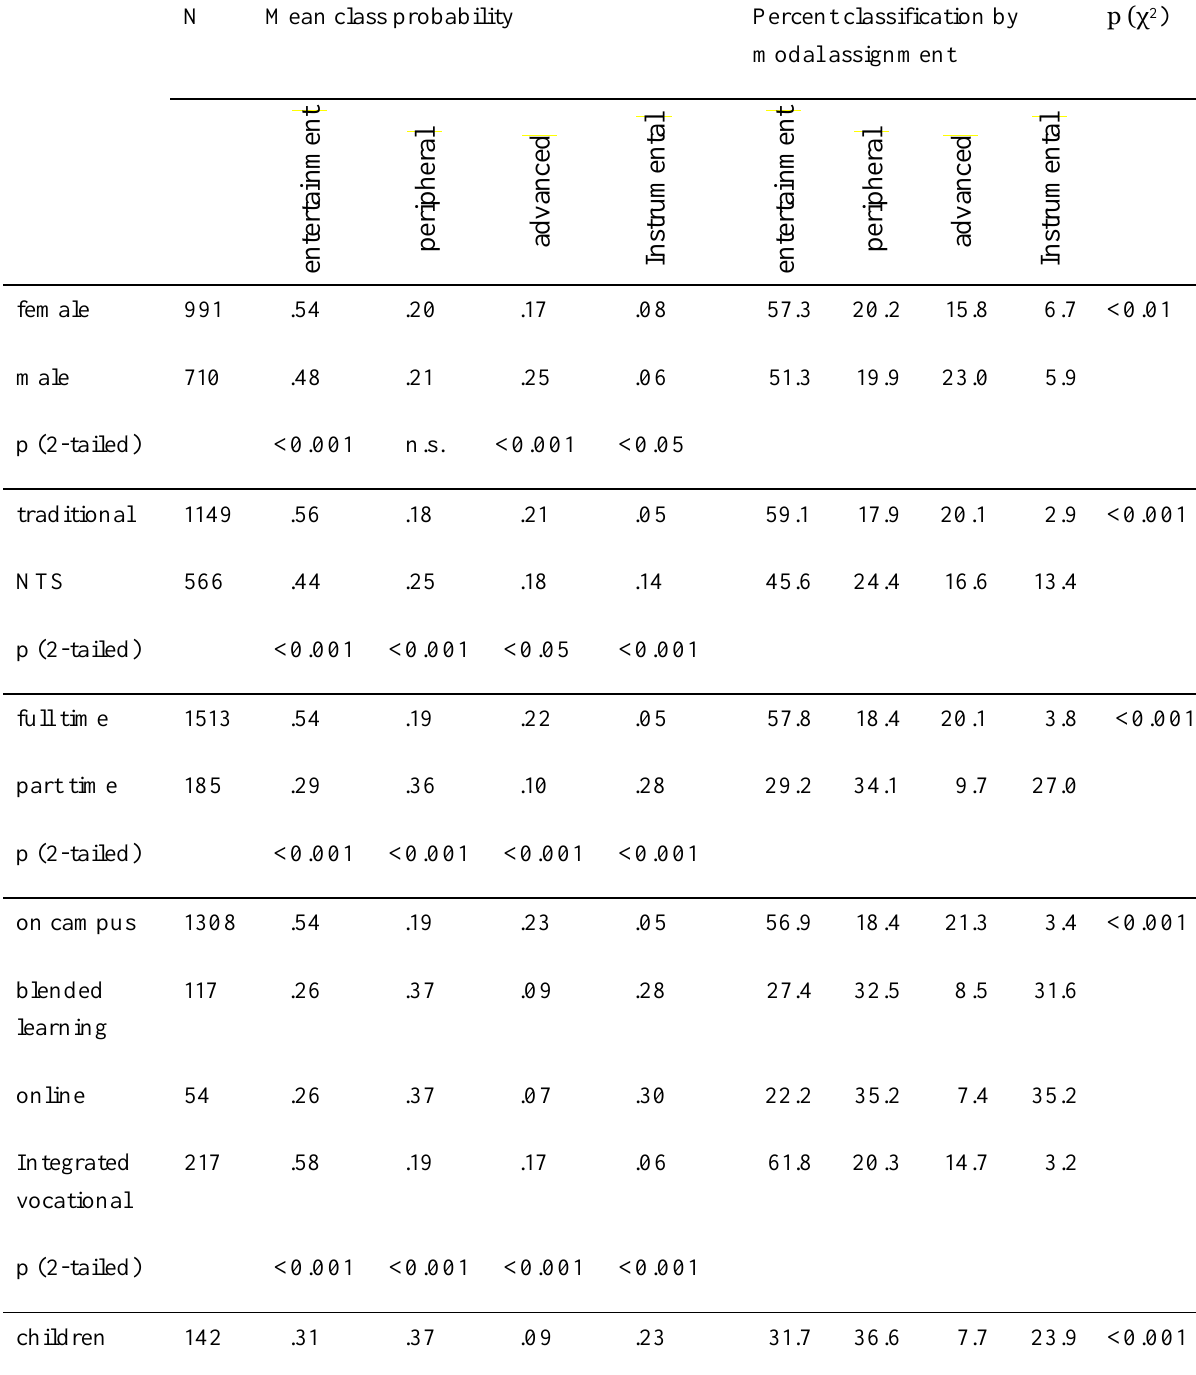
Percent classification